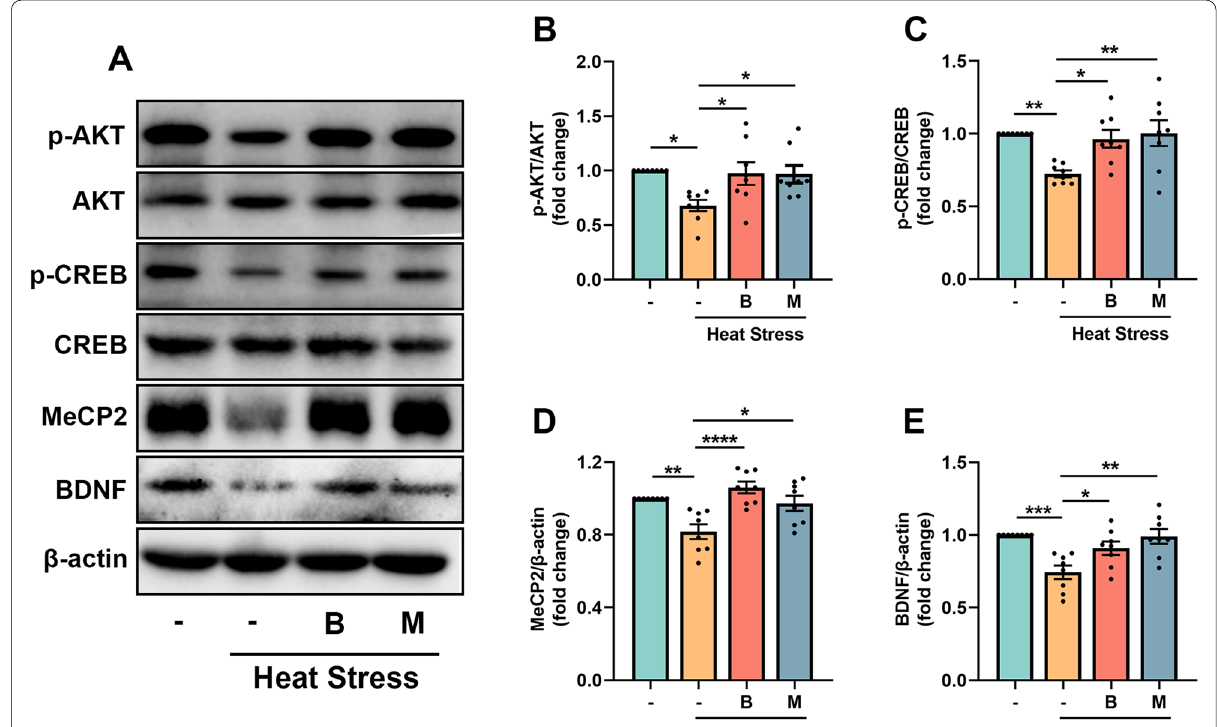
Fig. 7 BHBA activates the Akt-CREB-BDNF and MeCP2 pathways in the heat stress-treated mice. A Representative western blot bands showing the relative protein expression of p-Akt, Akt, p-CREB, CREB, MeCP2, and BDNF. B - E Quantitative analysis showing the ratio of p-Akt/Akt ( B ), p-CREB/ CREB ( C ), and the level of MeCP2 ( D ) and BDNF ( E ). Note that the phosphorylation of Akt and CREB and the expression of MeCP2 and BDNF were decreased in the heat stress-treated group, compared to the control group. However, BHBA treatment increased these protein levels in the heat stress-treated mice. Data were normalized to β-actin: expression of the target protein intensity of target protein band/intensity of β-actin. The = results are presented as the ratio of the experimental group to the control group with the value taken as 1. All data analyses were performed using one-way ANOVA with Tukey’s post-test. Data are represented as mean SEM. B‑E n 8. * p < 0.05, ** p < 0.01, *** p < 0.001, **** p < 0.0001. Akt, protein ± = kinase B; B, BHBA; BDNF, brain-derived neurotrophic factor; CREB, cAMP response element binding protein; M, minocycline; MeCP2, methyl-CpG binding protein